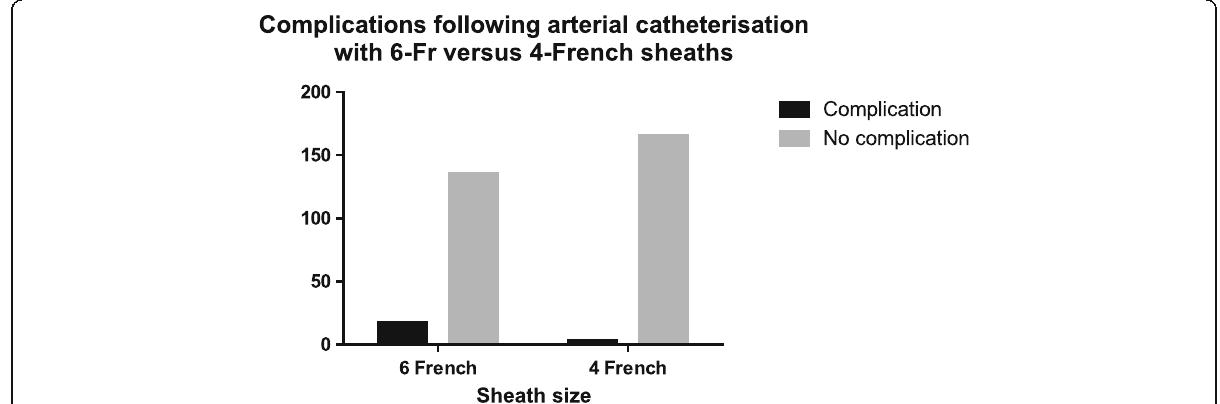
Fig. 1 Bar-chart demonstrating lower complication rates following 4-Fr arterial catheterisation compared with 6-Fr systems. Legend: Complications following arterial catheterisation with 6-Fr versus 4-Fr